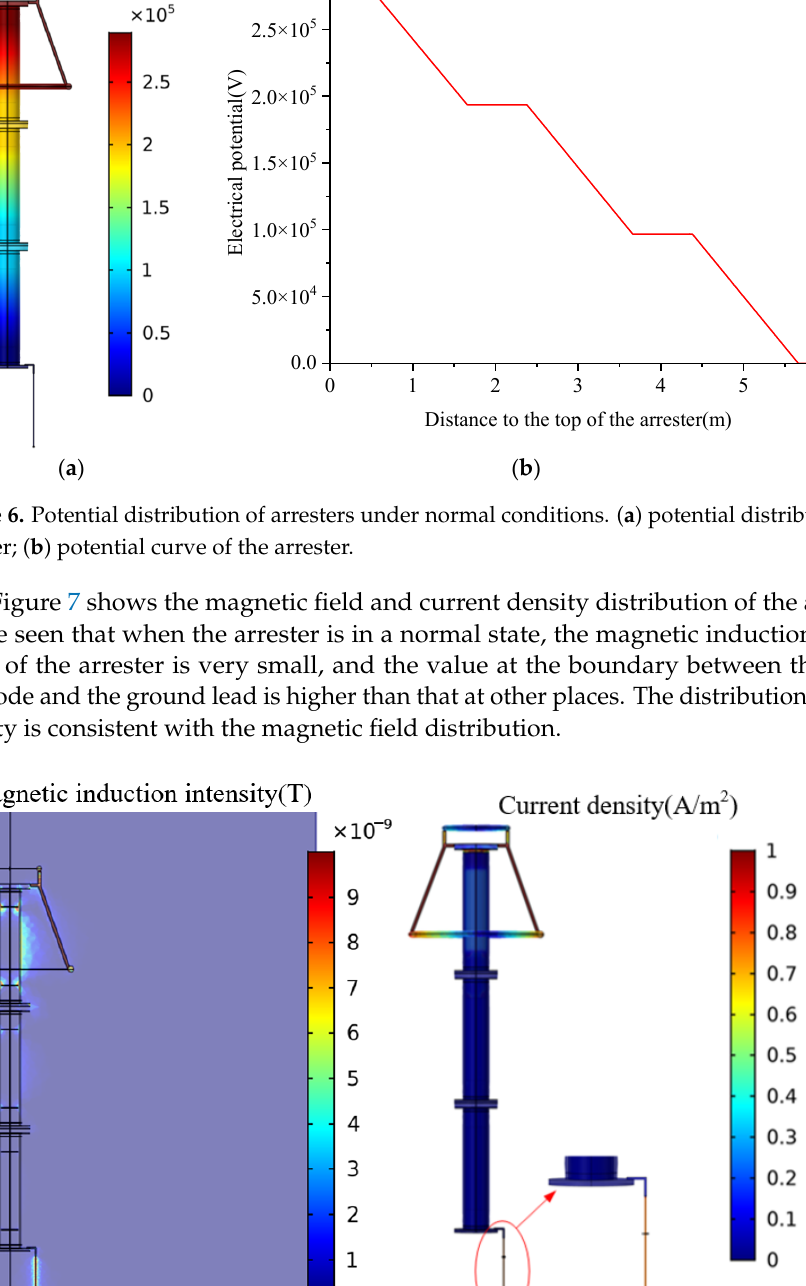
sity distribution. density